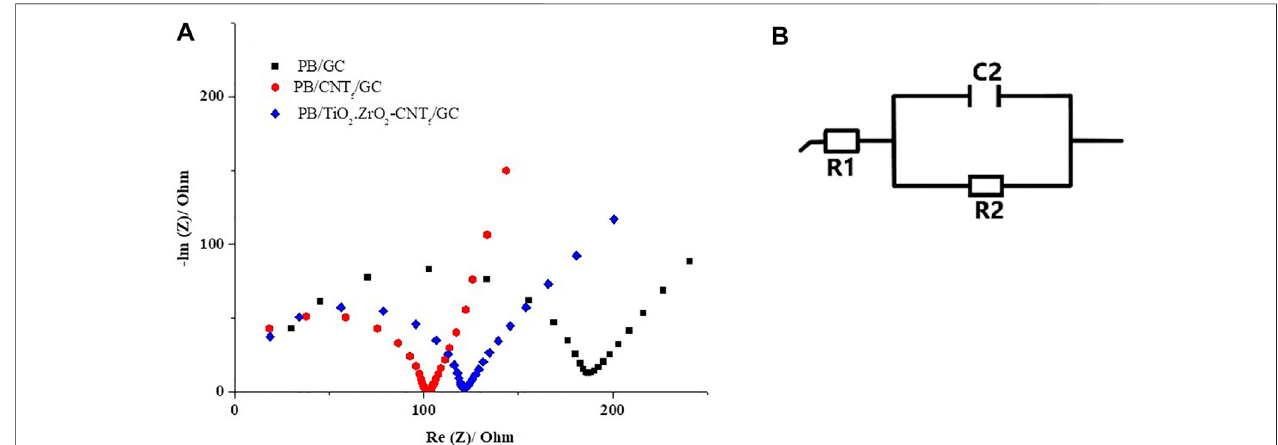
FIGURE 12 | (A) Nyquist plots: PB/GC, PB/fCNT/GC, and PB/TiO 2 .ZrO 2 - fCNT/GC-modi fi ed electrodes in 7.5 mmol L H 2 O 2 in 0.1 mol 1.1 mol/L. PBS (pH 3.0). (B) Equivalent circuit of the three electrodes.